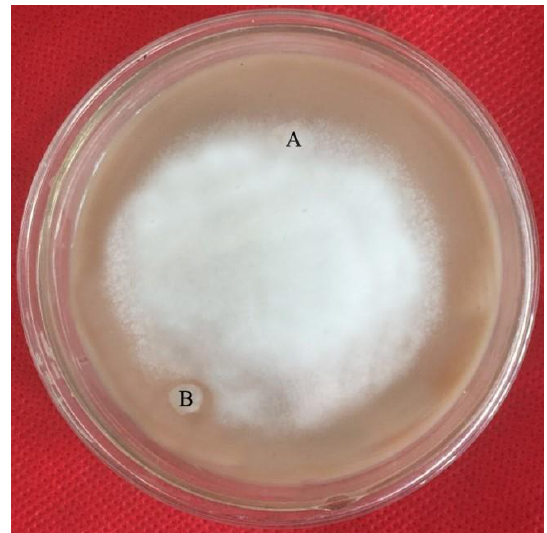
Figure 13. Inhibition of the P. infestans with lectin ( B ) and stroke-physiological saline solution ( A ).